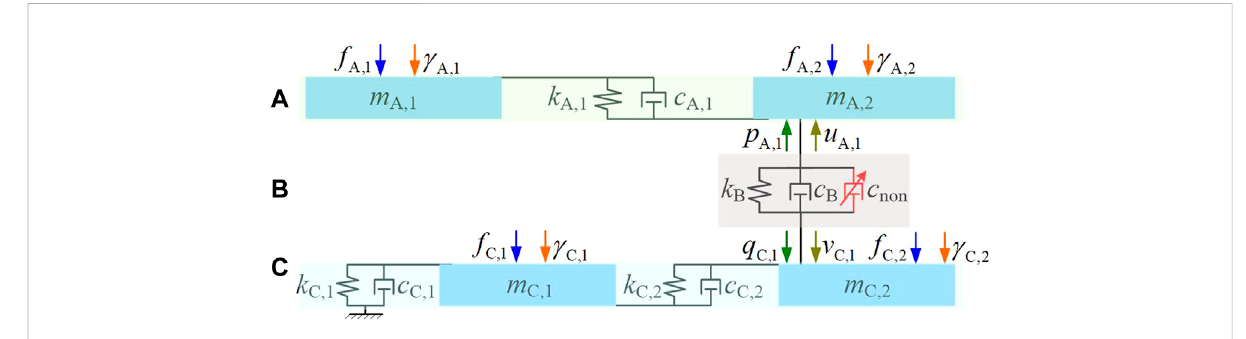
FIGURE 8 Three layer MIMO model of the 4-DoF nonlinear damped building isolation system.